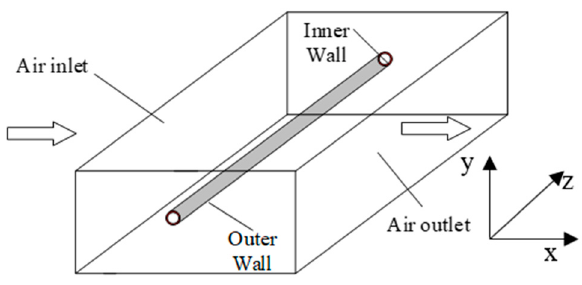
Figure 1. Geometric model. Table 1. Physical properties parameters.